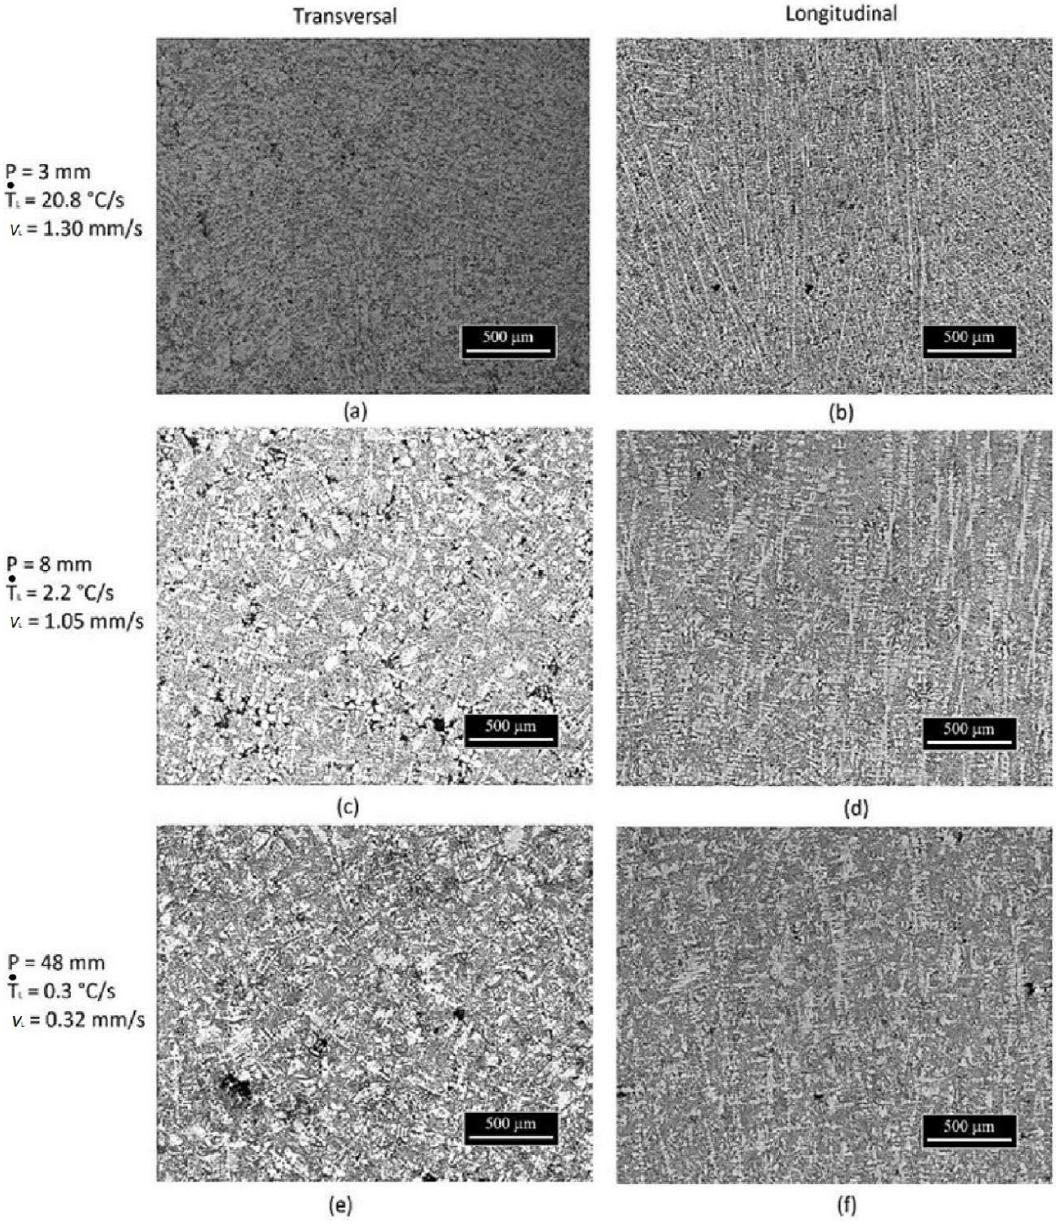
Figure 7. Optical microstructures representing different positions along the casting length, that is, different cooling rates during solidification of the Al-11wt. %Si-4.5wt. %Cu alloy: ( a,b ) P = 3 mm, ( c,d ) P = 8 mm and ( e,f ) P = 48 mm.